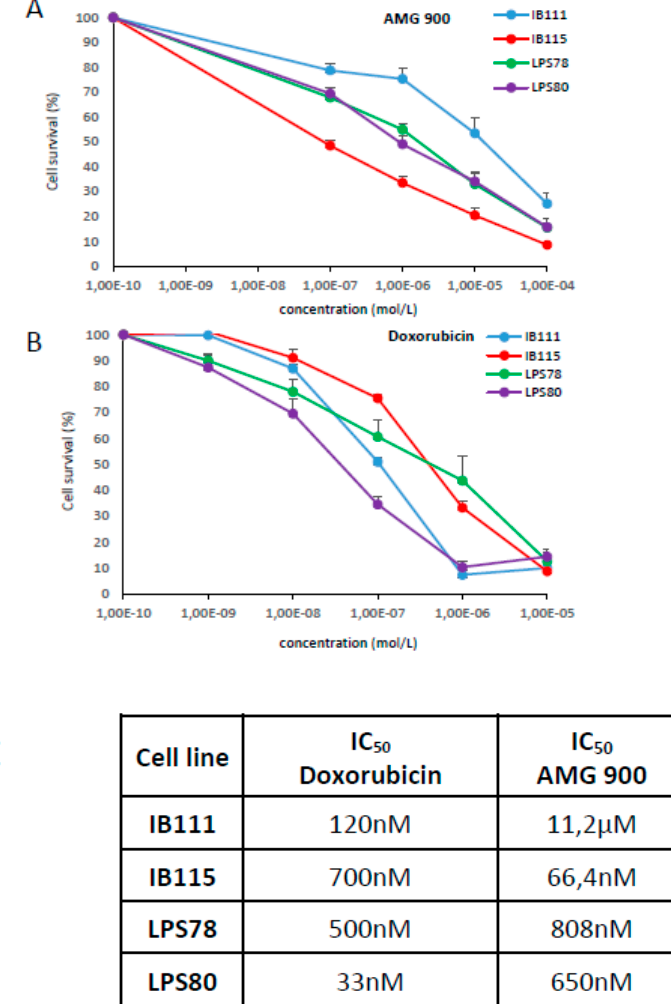
Figure 4. Comparative cytotoxic effects of AMG 900, a pan AURK inhibitor and the doxorubicin on LPS. Four LPS cell lines were challenged for 72 h with increasing doses of drug ( A : AMG 900, B : Doxorubicin) to determine the corresponding IC 50 on cell survival. After treatment, surviving cell were quantified with MTT assay. Graphs represent mean values of at least three independent experiments +/ − SEM. ( C ) Recapitulative table of IC50 for LPS cells lines.